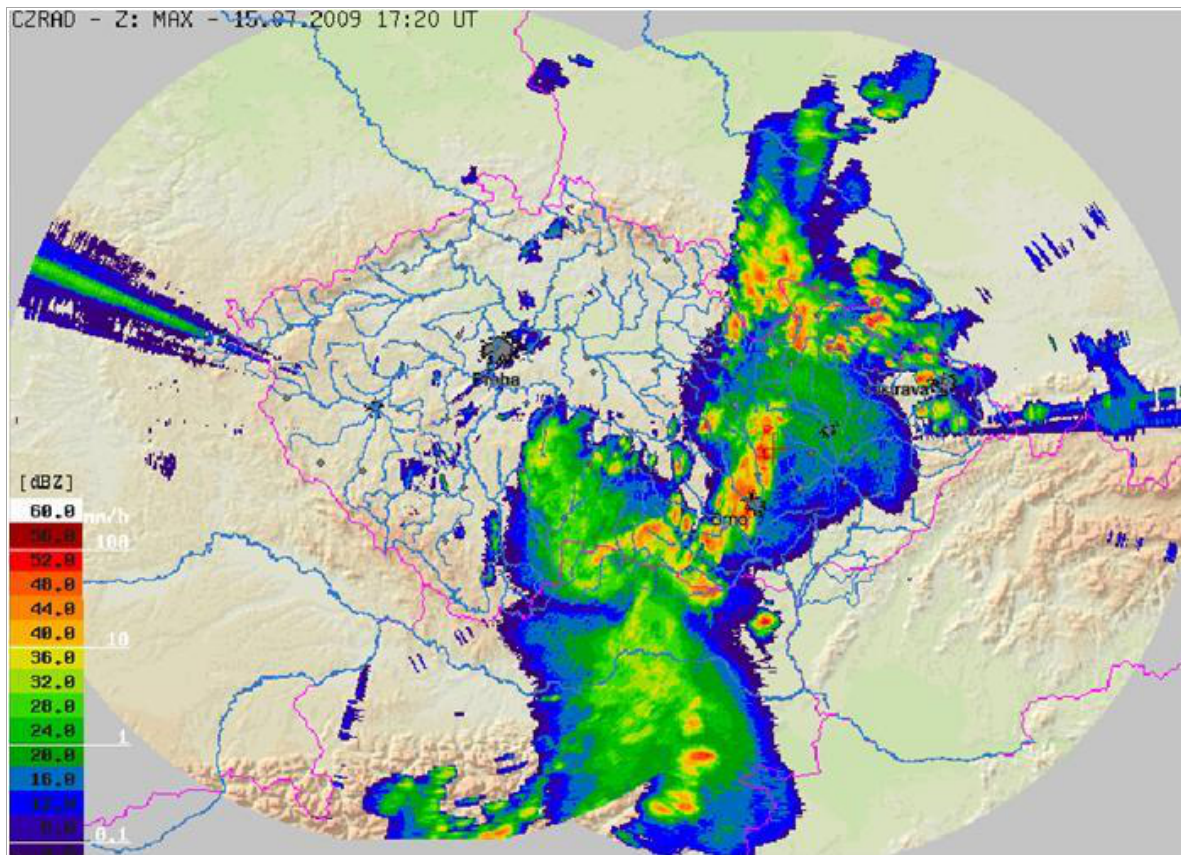
Fig. 4. The radar reflectivity on July 15, 2009 in the Czech